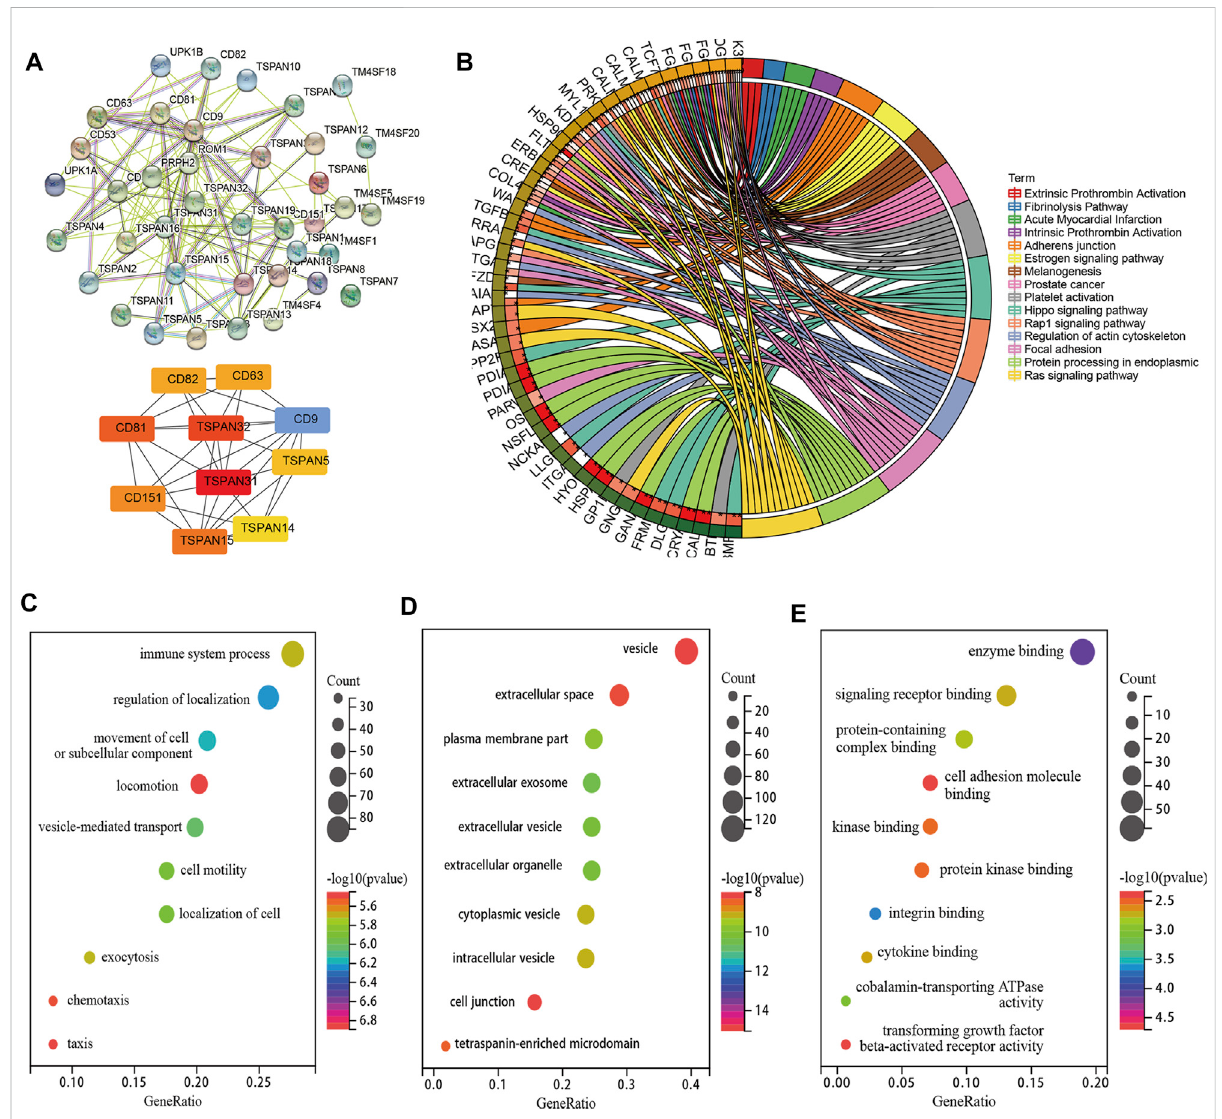
FIGURE 3 PPINetwork,Co-ExpressionandFunctionalEnrichmentAnalysesofTM4SFsinPatientsWithPTC. (A) PPInetworkconnectivityforproteinsthat co-expressed with TM4SF members via STRING and hub genes from the PPI network via cytoHubba plug-in and the MCC algorithm. KEGG (B) and GO [ (C) Cellular Component; (D) Biological Process; (E) Molecular Function] enrichment analyses of those TM4SFs and co-expressed genes.